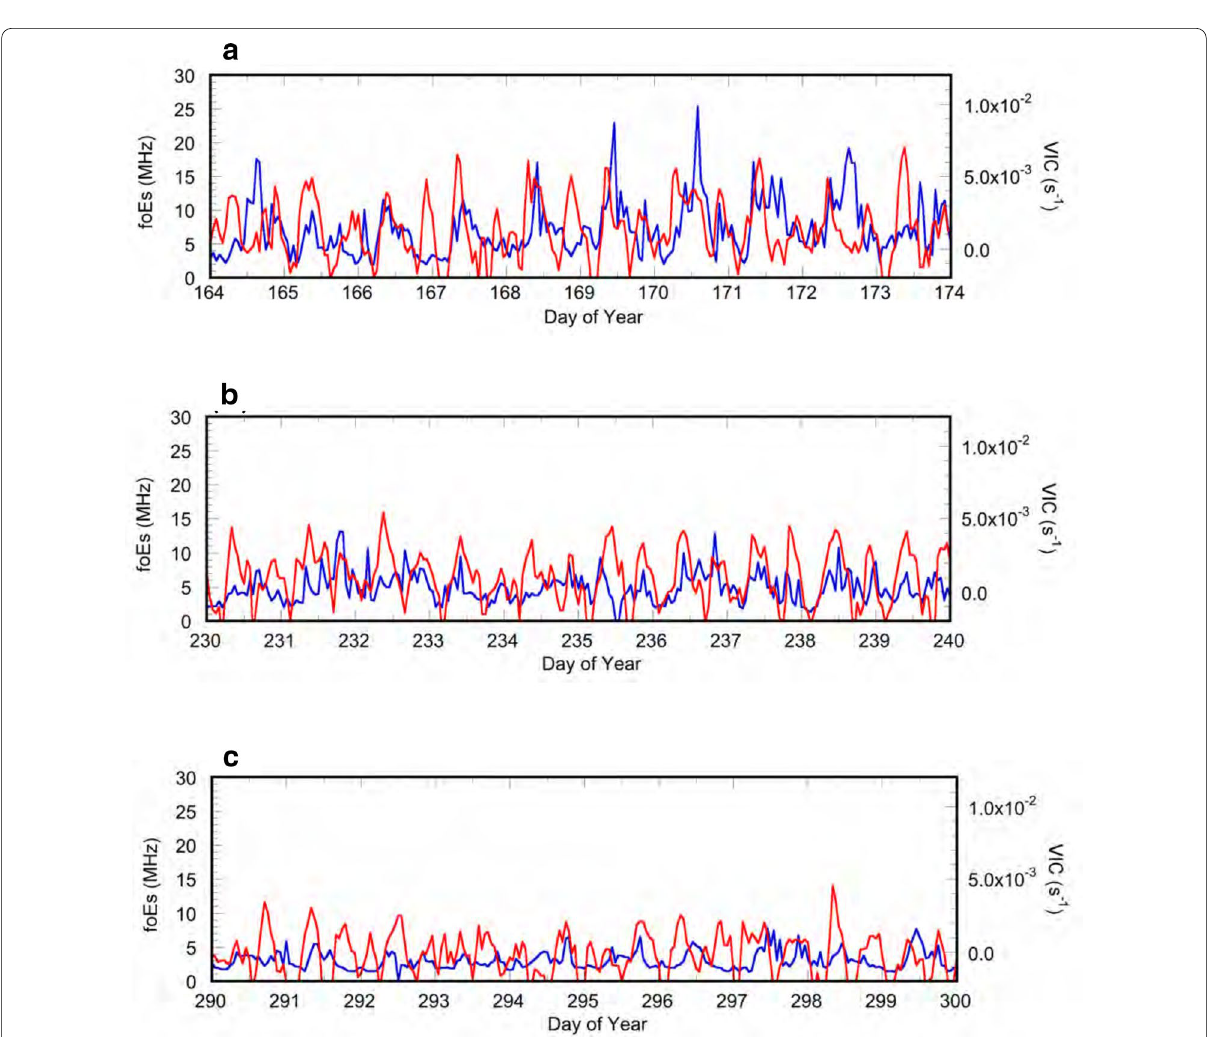
Fig. 8 One-hour values of foEs and VIC 120 . One-hour values of foEs (blue line) and the vertical ion convergence at 120 km altitude ( VIC 120 ) (red line) are plotted for three different periods at Kokubunji in 2009. a corresponds to the most active period, and b , c are moderate and quiet periods,